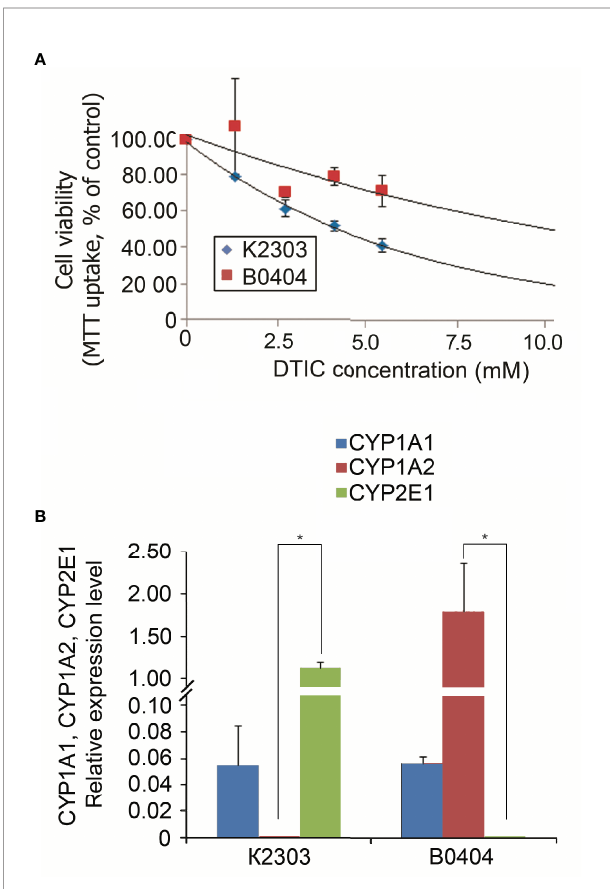
FIGURE 1 | (A) Sensitivity of melanoma cell lines K2303 and B0404 to dacarbazine. 3-(4,5-dimethylthiazol-2-yl)-2,5-diphenyltetrazolium bromide- assay-based dose-response curves were used to estimate the 50% inhibitory concentration. IC 50 was calculated using the GraphPad Software Prism 7.05/ e Data are presented as the mean±SEM. (B) Relative CYP1A1 , CYP1A2 and CYP2E1 gene expression levels according to reverse transcription- quantitative polymerase chain reaction in K2303 and B0404 melanoma cells. Data are presented as the mean±SEM. *P<0.05 by Mann-Whitney U test for unpaired